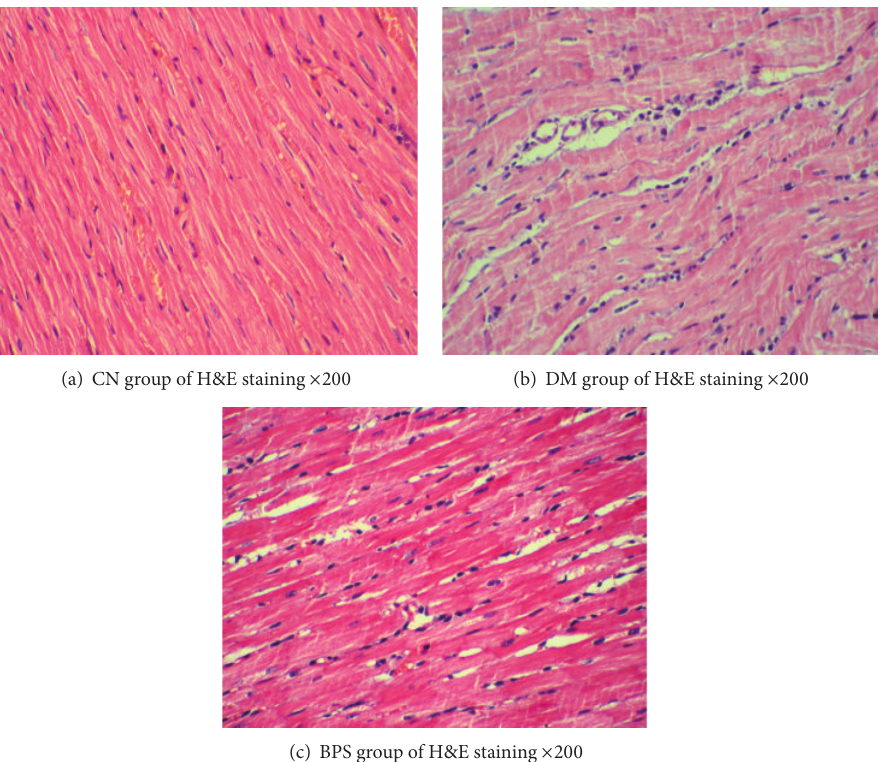
Figure 14: (a–c): H&E staining results. Cardiac structure of CN group was normal (a); H&E staining in DM group shows the cardiac muscle fibers derangement, the widening gap, the pyknotic and fragmented nuclei, and the increased apoptosis (b); after BPS treatment, the pathological damage significantly alleviated compared with the DM group (c).